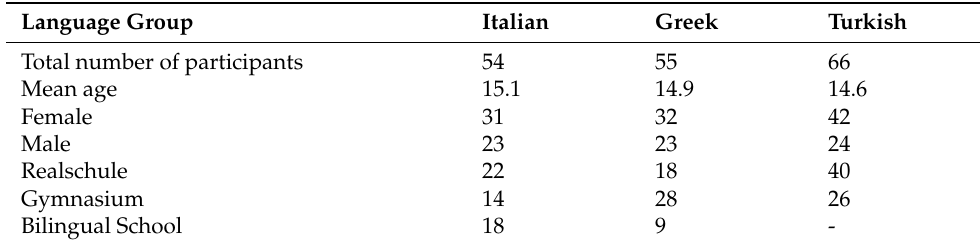
Table 1. Demographic data of the